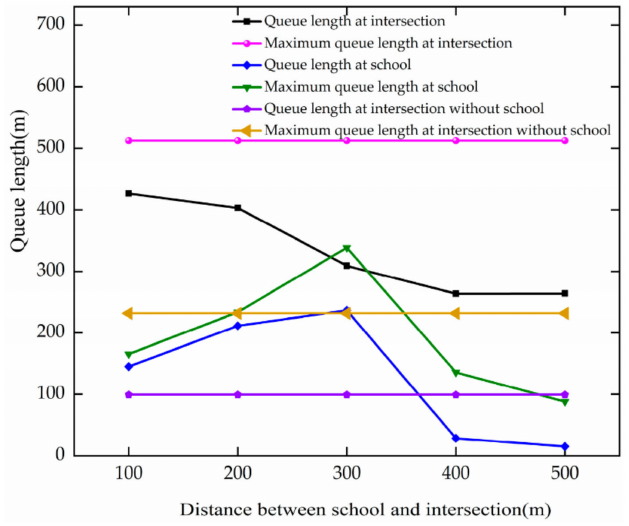
Figure 20. Variation trend of queue length with